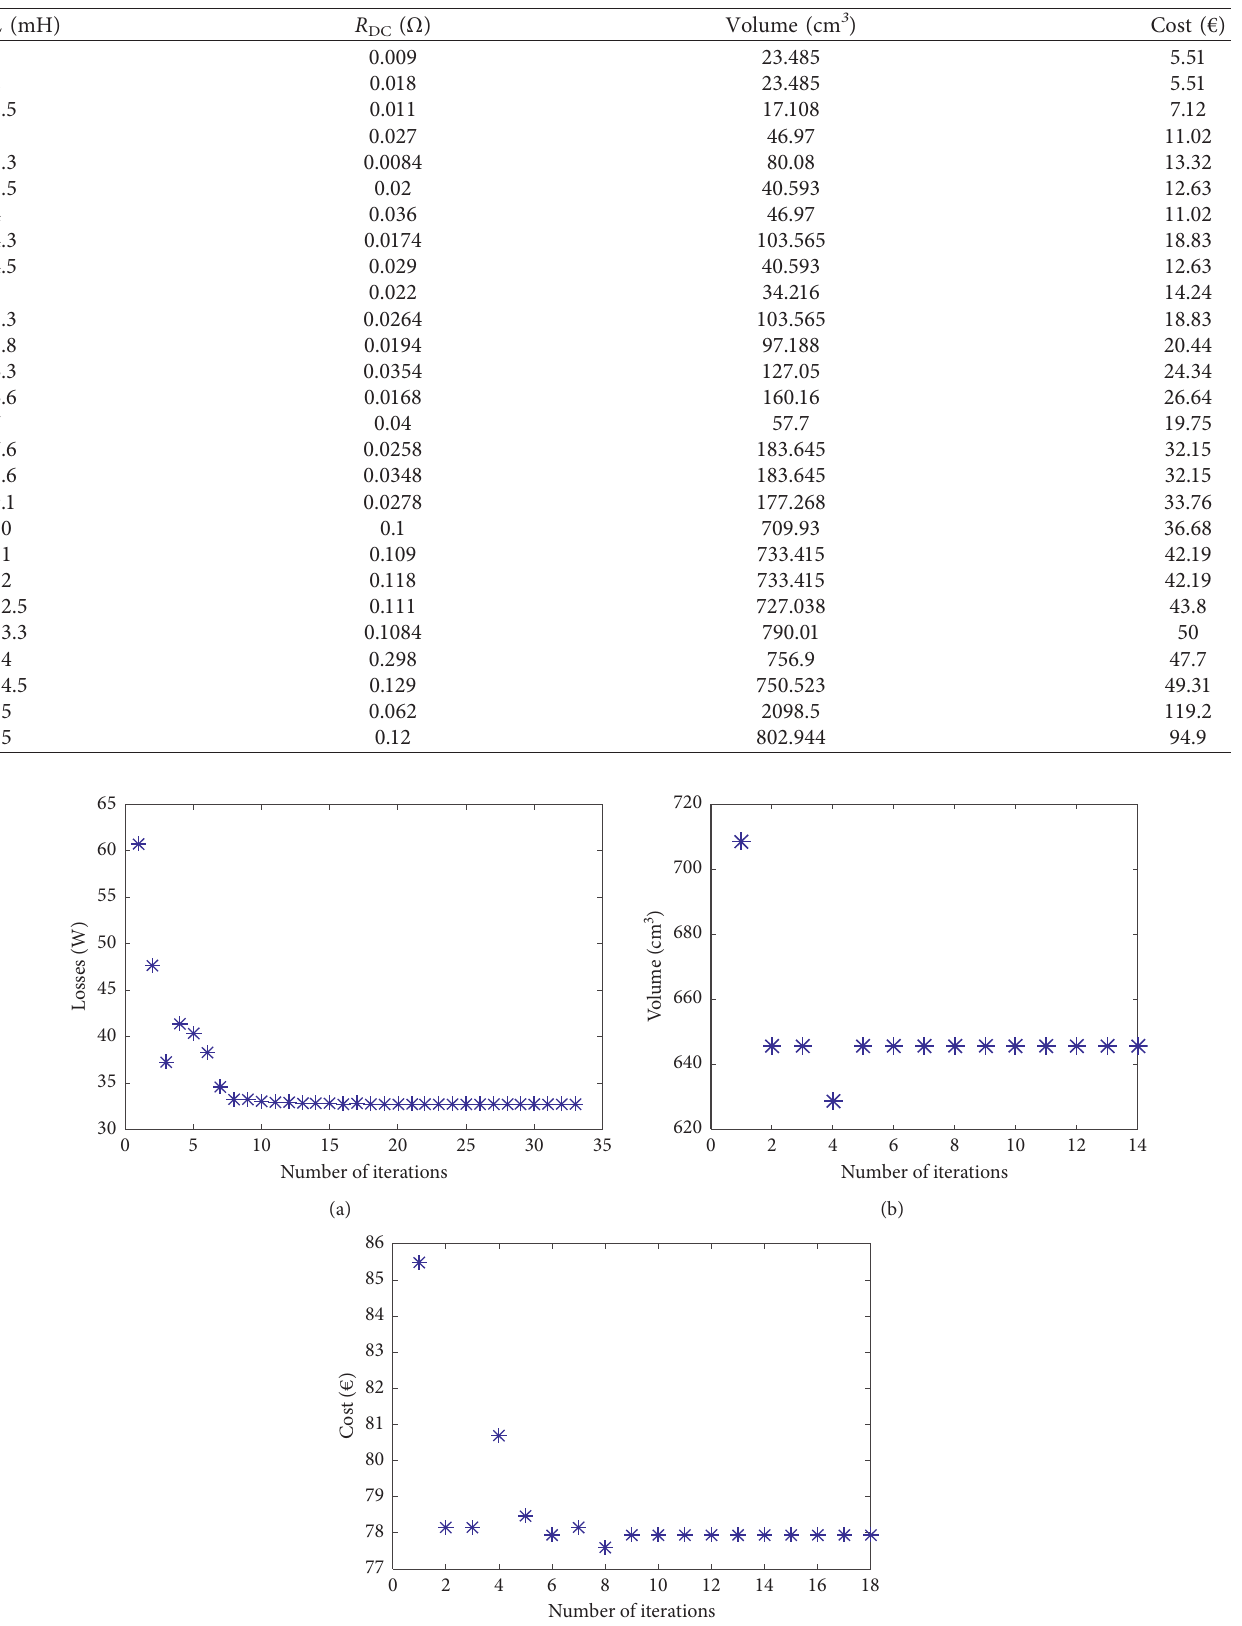
Table 4: Output inductor database.